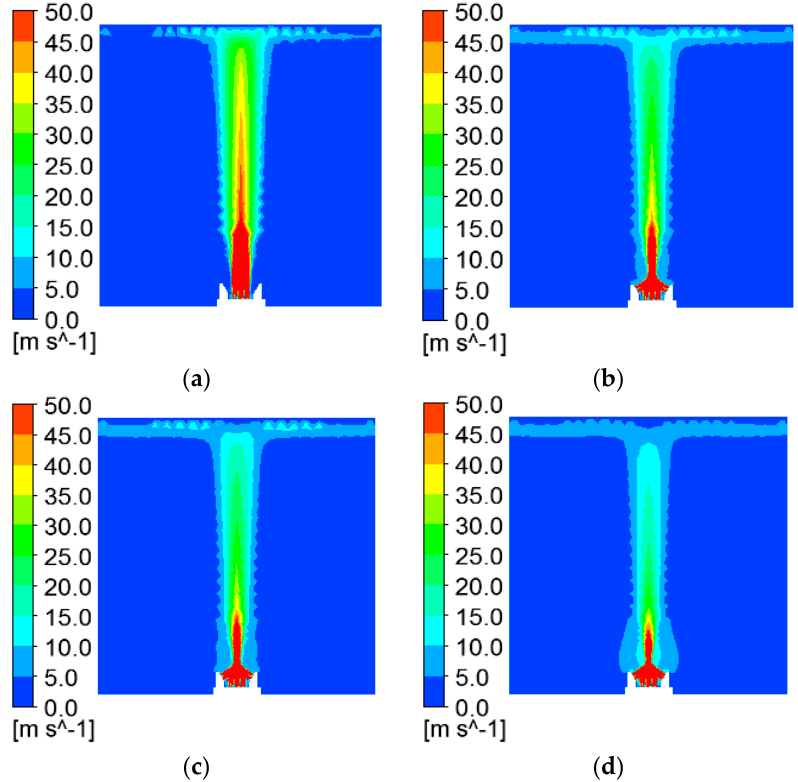
Figure 6. Velocity contours along the short axis for four shaping air pressures: ( a ) 0 MPa; ( b ) 0.02 MPa; ( c ) 0.05 MPa; ( d ) 0.07 MPa.